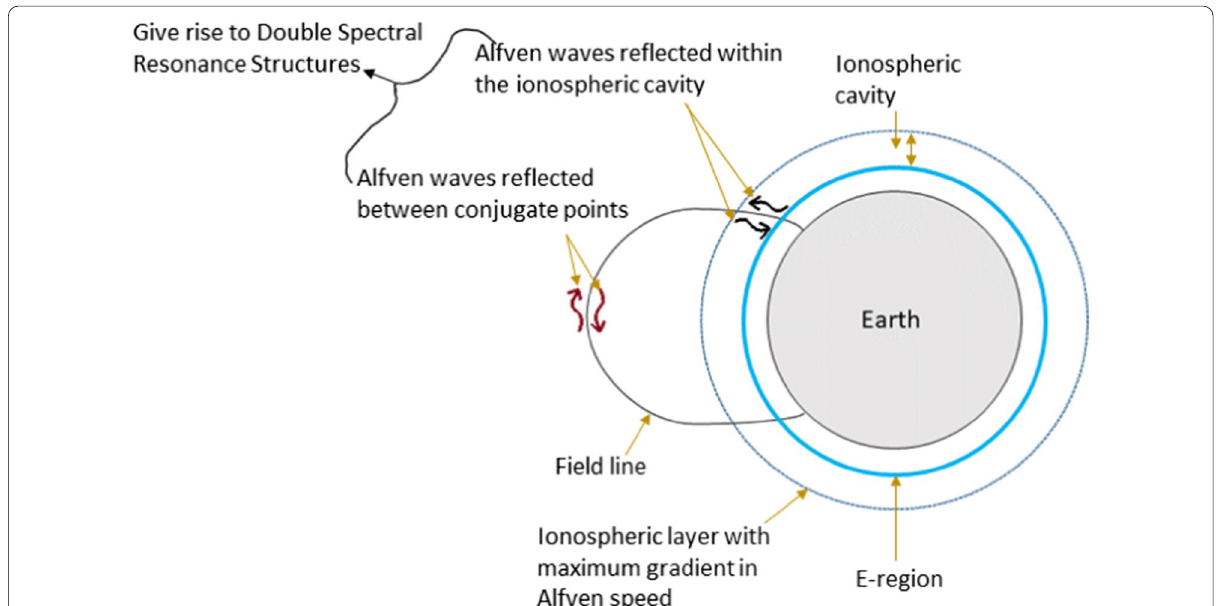
Fig. 9 Pictorial representation of a possible mechanism of excitation of double spectral resonance structures